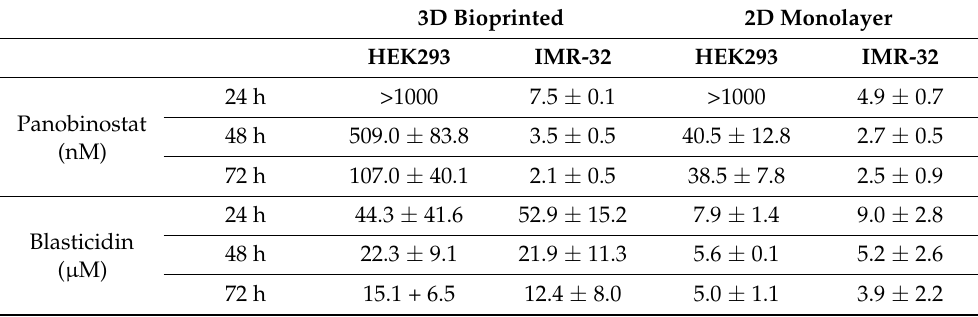
Table 1. IC 50 values of HEK293 and IMR-32 cells treated with panobinostat or blasticidin in 3D constructs or 2D